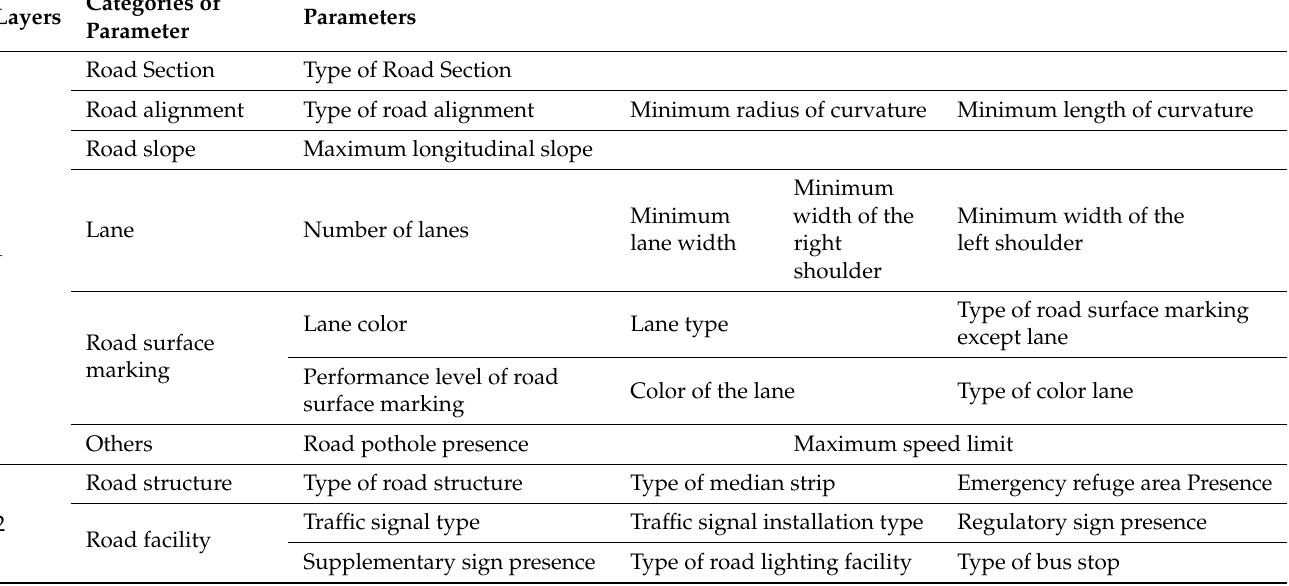
Table 2. Logical scenario